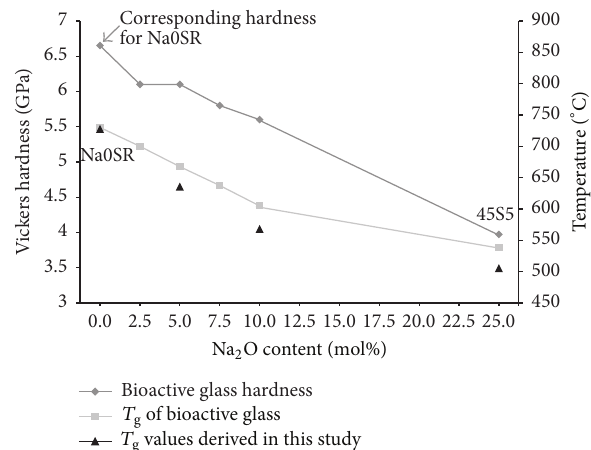
Figure 6: 𝑇 and Vickers hardness values adapted from Farooq et al. g 2013 [24], as comparison.